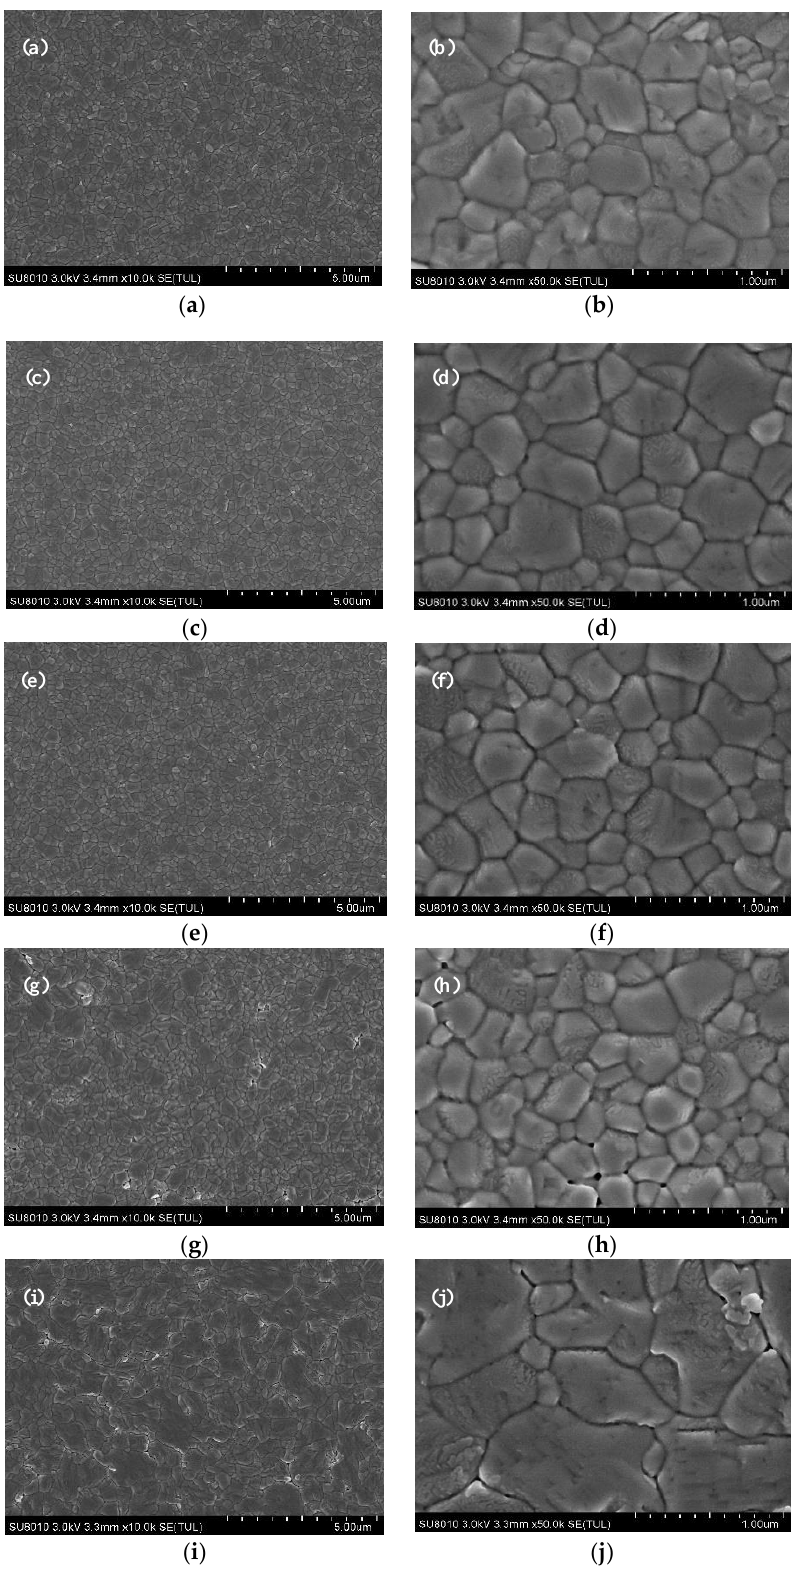
Figure 5. SEM images of perovskite film prepared on nano TiO 2 optimized with (6,6)-phenyl c 61 butyric acid methyl ester (PC 61 BM) of different concentration: ( a , c , e , g , i ) The low magnification; ( b , d , f , h , j ) The high magnification.